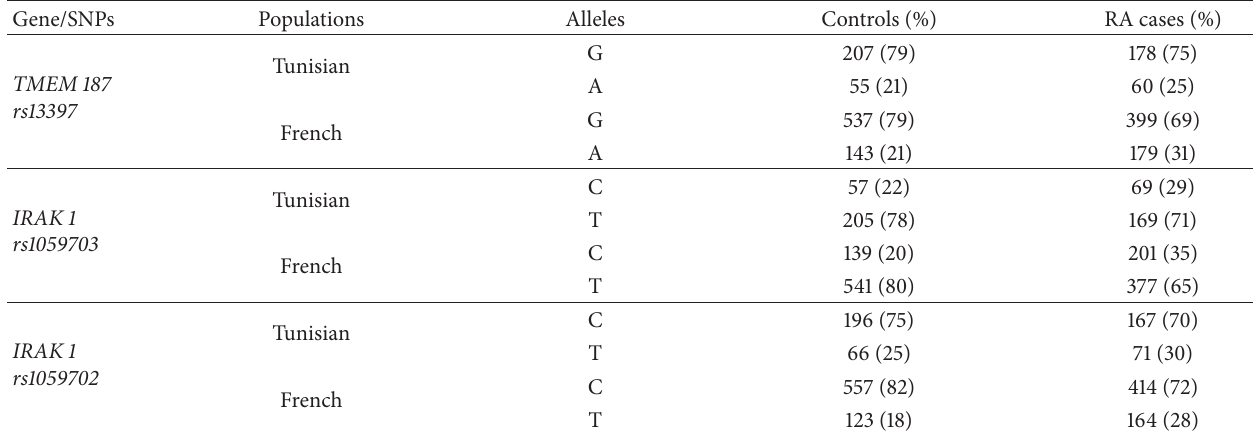
Table 4: TMEM187-IRAK1 allelic frequencies in samples of RA and healthy controls from Tunisian and French female